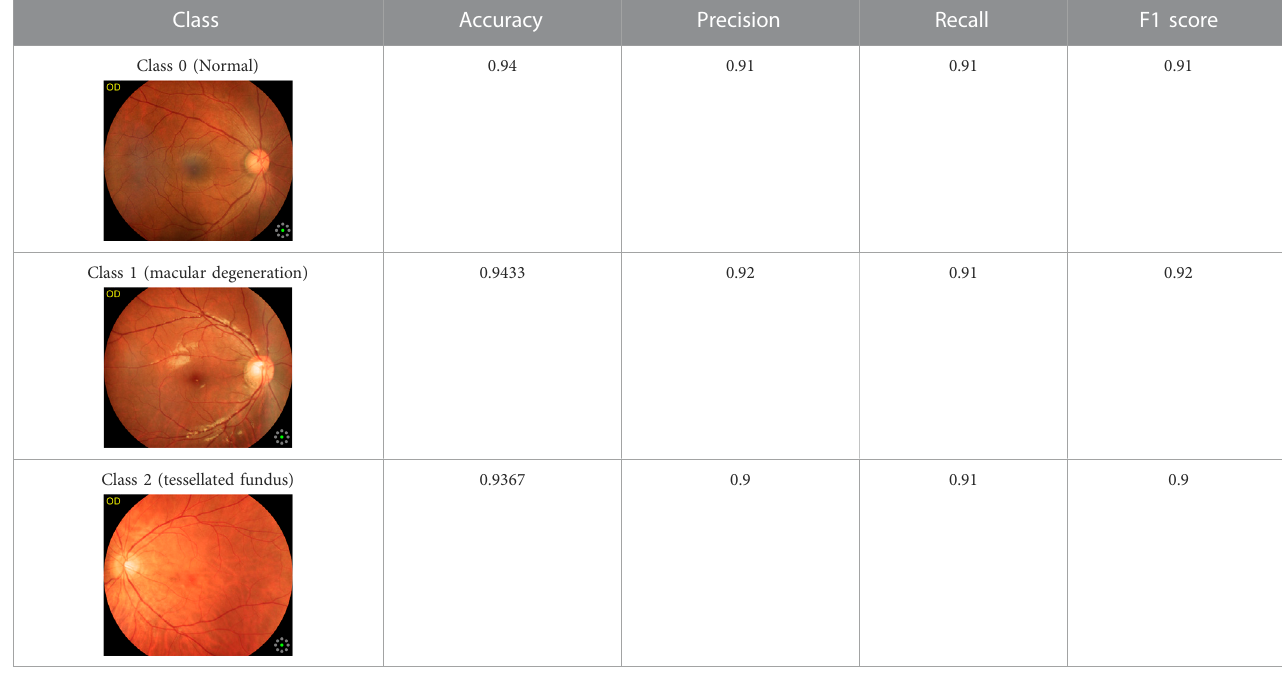
TABLE 5 Performance evaluation for each class using.